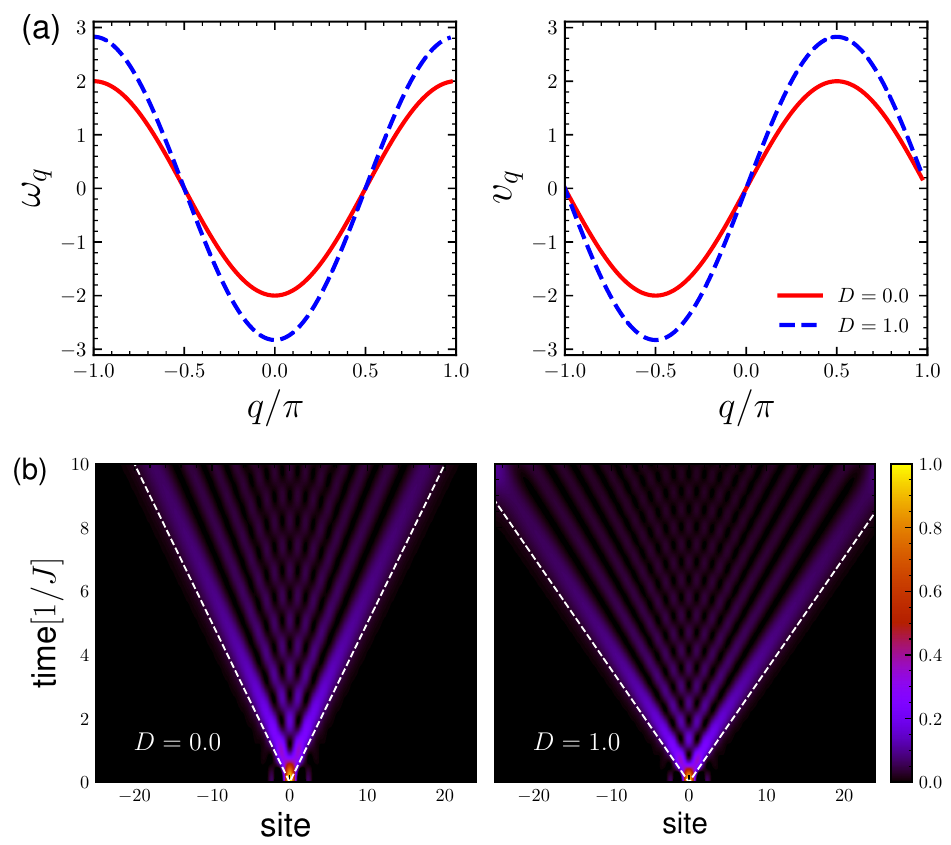
ω = d q are g dq | c † | ψ 〉 versus time. Excita- c t j t j = 2˜ J , max